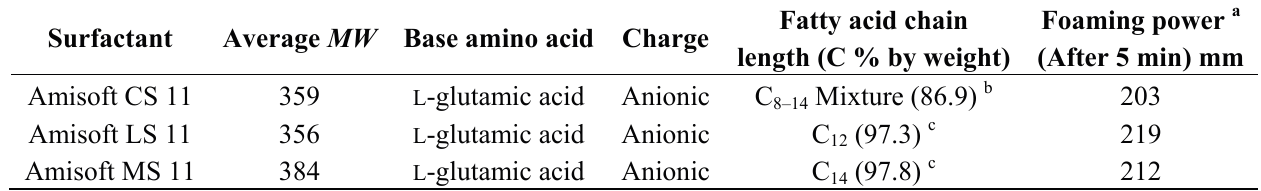
Table 1. Physico-chemical properties of acylglutamate